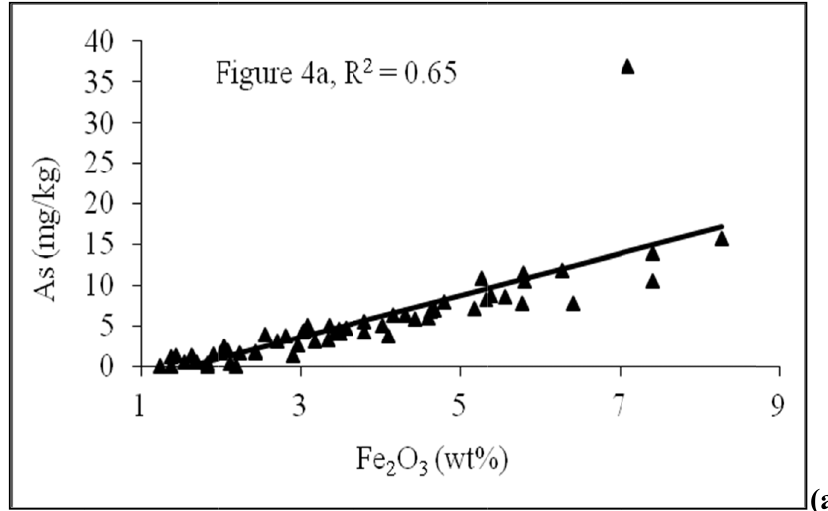
ma, e 4. Relatio oxonships of A ( d ) anganese xide in Maru